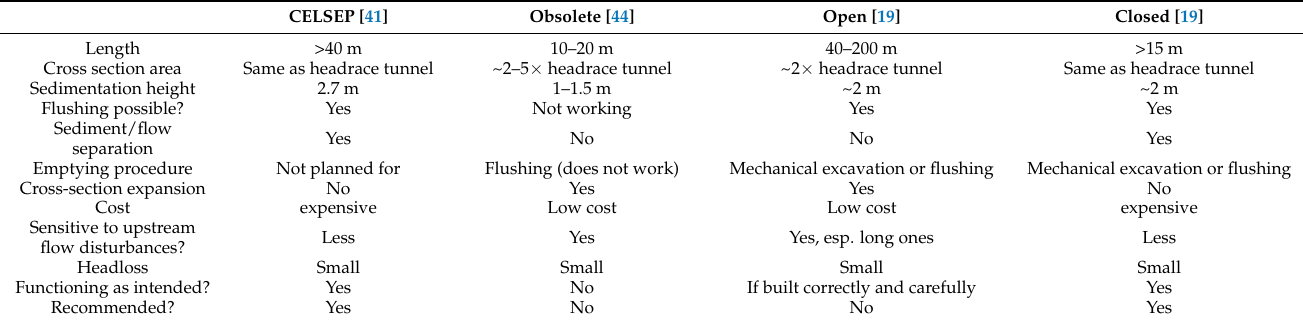
Table 1. Comparison between different types of rock trap designs.